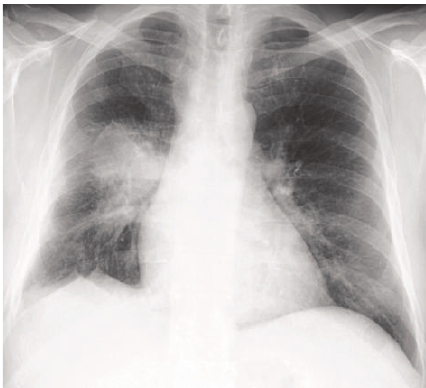
Figure 1: CXR showing right lower lobe mass lesion at the time of presentation.